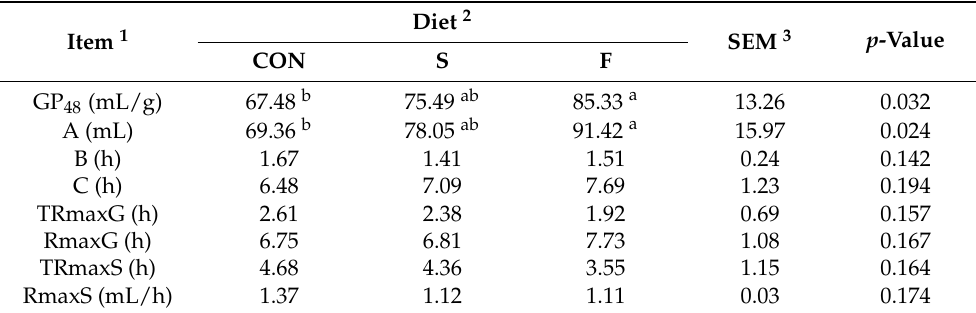
Table 3. Effects of oilseed treatments on in vitro gas production and kinetic parameters.